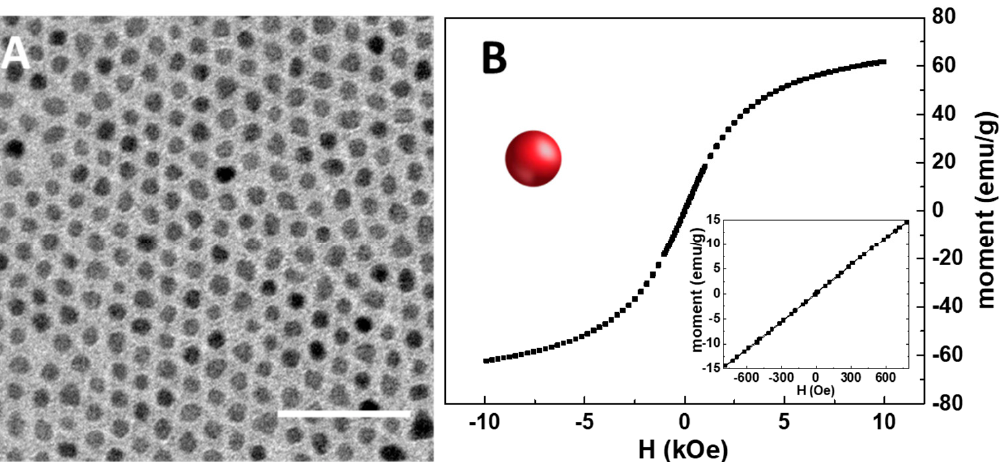
Figure 2. TEM micrograph of the organic-capped SPIONs dissolved in chloroform (scale bar 50 nm) ( A ). RT hysteresis cycle of organic-capped SPIONs ( B ). In the inset, details of the low field magnetization response are reported.